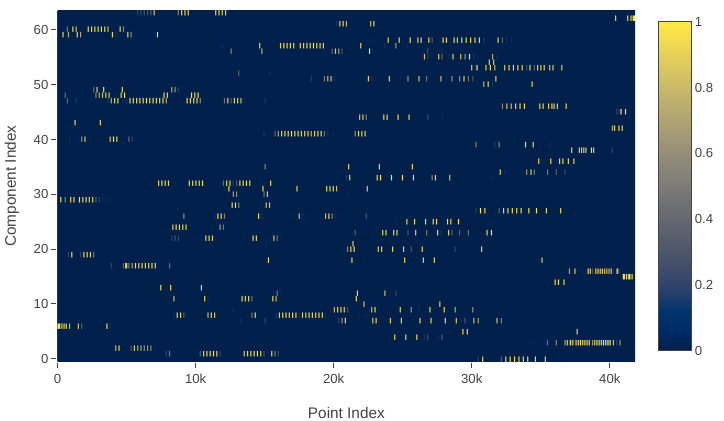
Figure 1. Visualized responsibility matrix. The dark region occupies a significant percentage, meaning the matrix is sufficiently